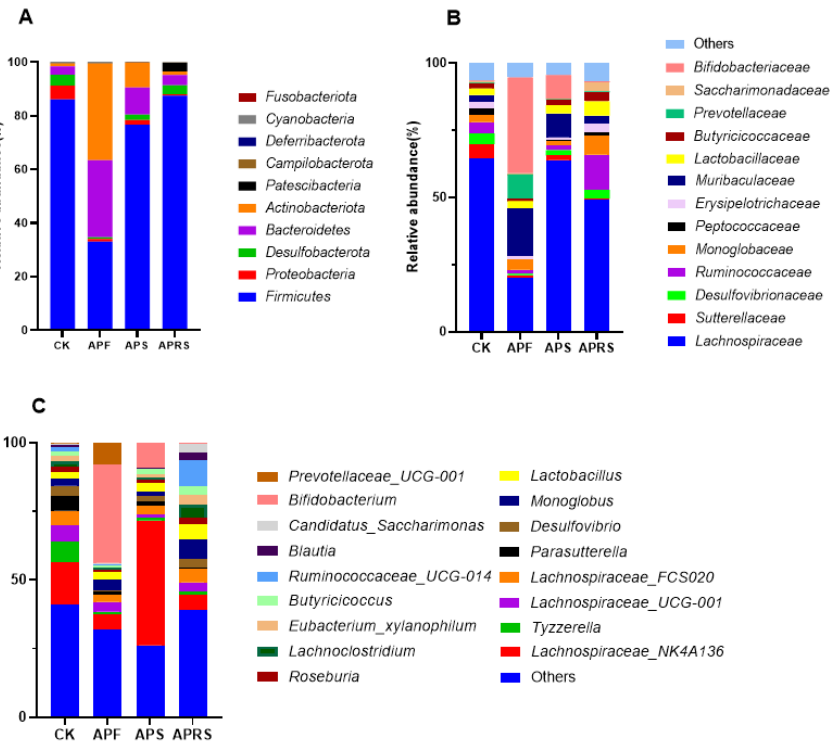
Figure 2. Fecal microbiota composition from mice after 8 weeks of feeding with APF, APS, and APRS. The composition of gut microbiota at the ( A ) phylum, ( B ) family, and ( C ) genus